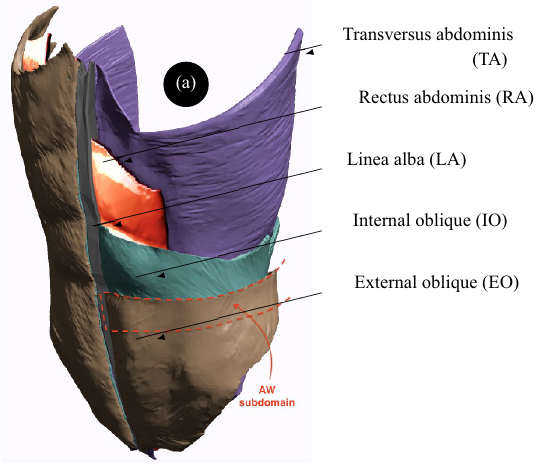
Figure 1. Anatomic geometry of AW where the upper regions of the left transversus abdominis, rectus abdominis, internal oblique, and external oblique were removed to better illustrate the